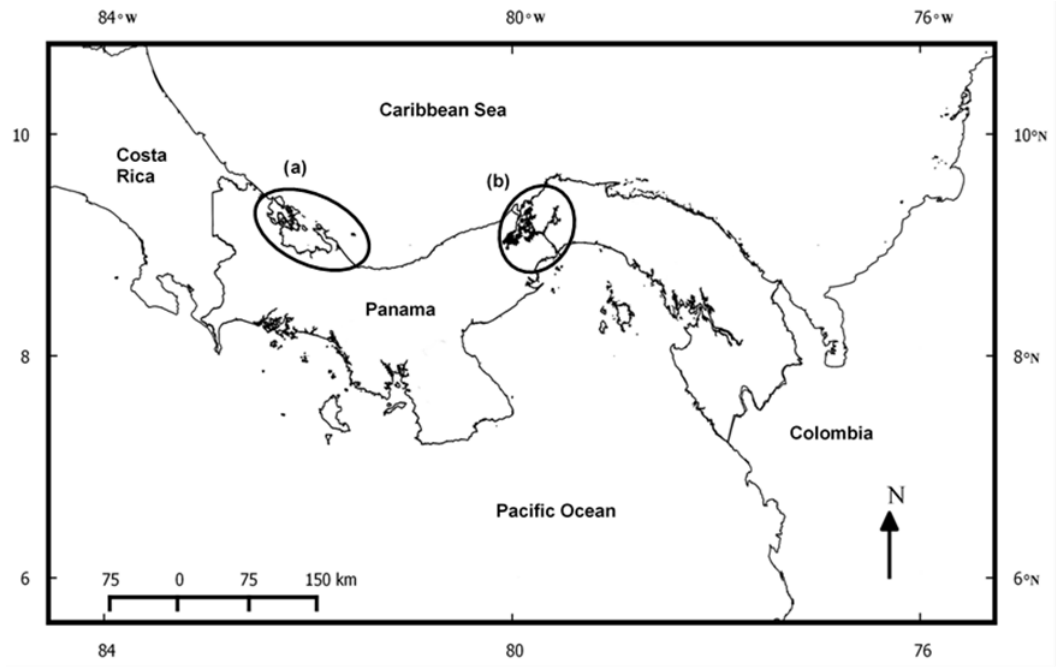
Figure 1. The two largest populations of West Indian manatees ( Trichechus manatus ) in Panama; ( a ) Bocas del Toro and ( b ) Lake Gatun, the main body of water for the operation of the Panama Canal. There are also occasional manatee sightings along the Caribbean coast of Panama.